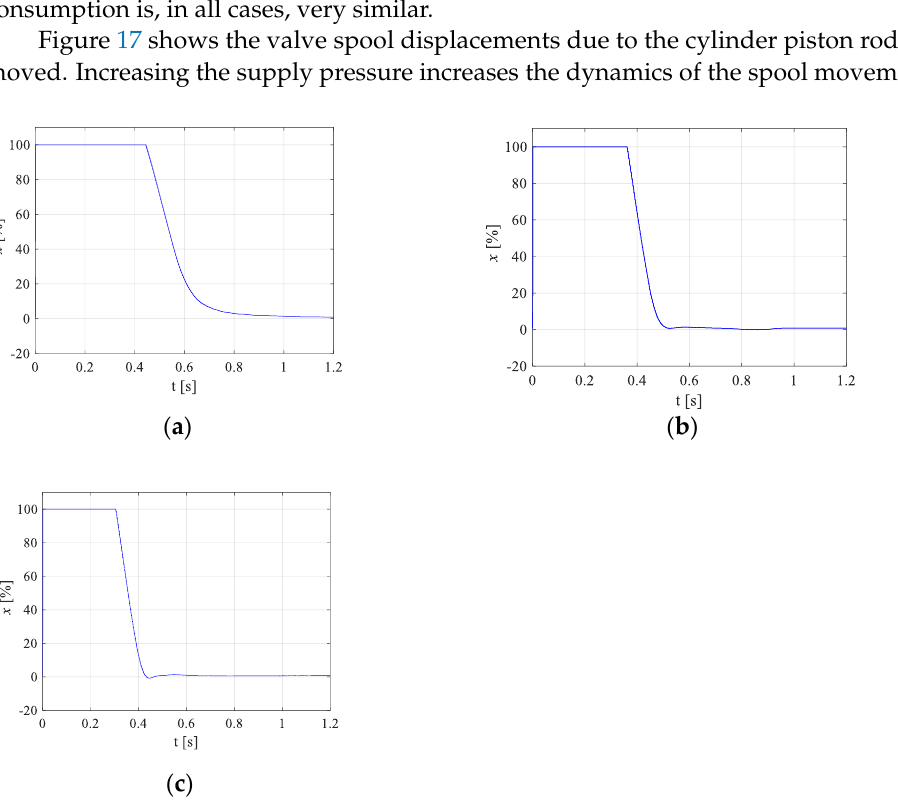
Figure 17. Spool displacements during drive moved with MFC controller: ( a ) p 0 = 4 MPa, F = 697 N, ( b ) p 0 = 8 MPa, F = 1477 N, ( c ) p 0 = 12 MPa, F = 1800 N.